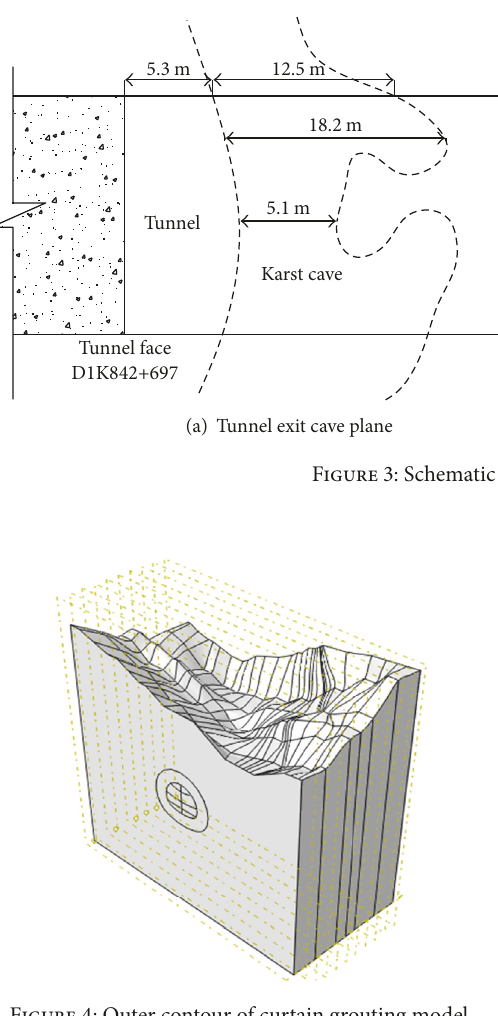
constraint; that is, restrict the 𝑋 -direction displacement in the left and right boundaries, restrict the 𝑌 -direction dis- placement on the bottom boundary; and leave the top surface